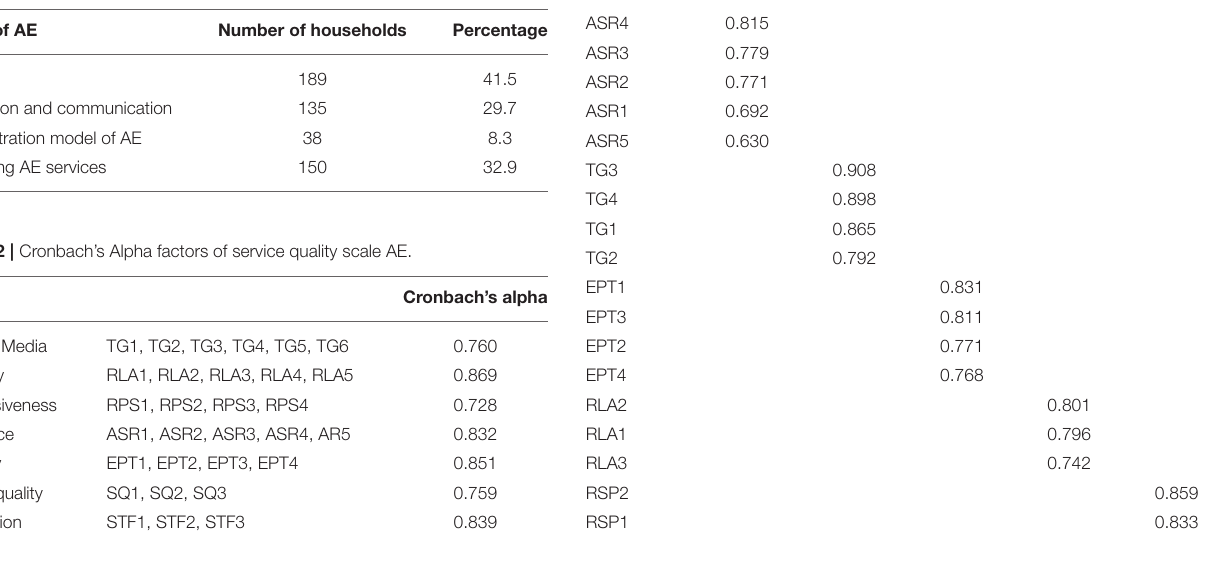
TABLE 1 | Local AE forms in Quang Binh.